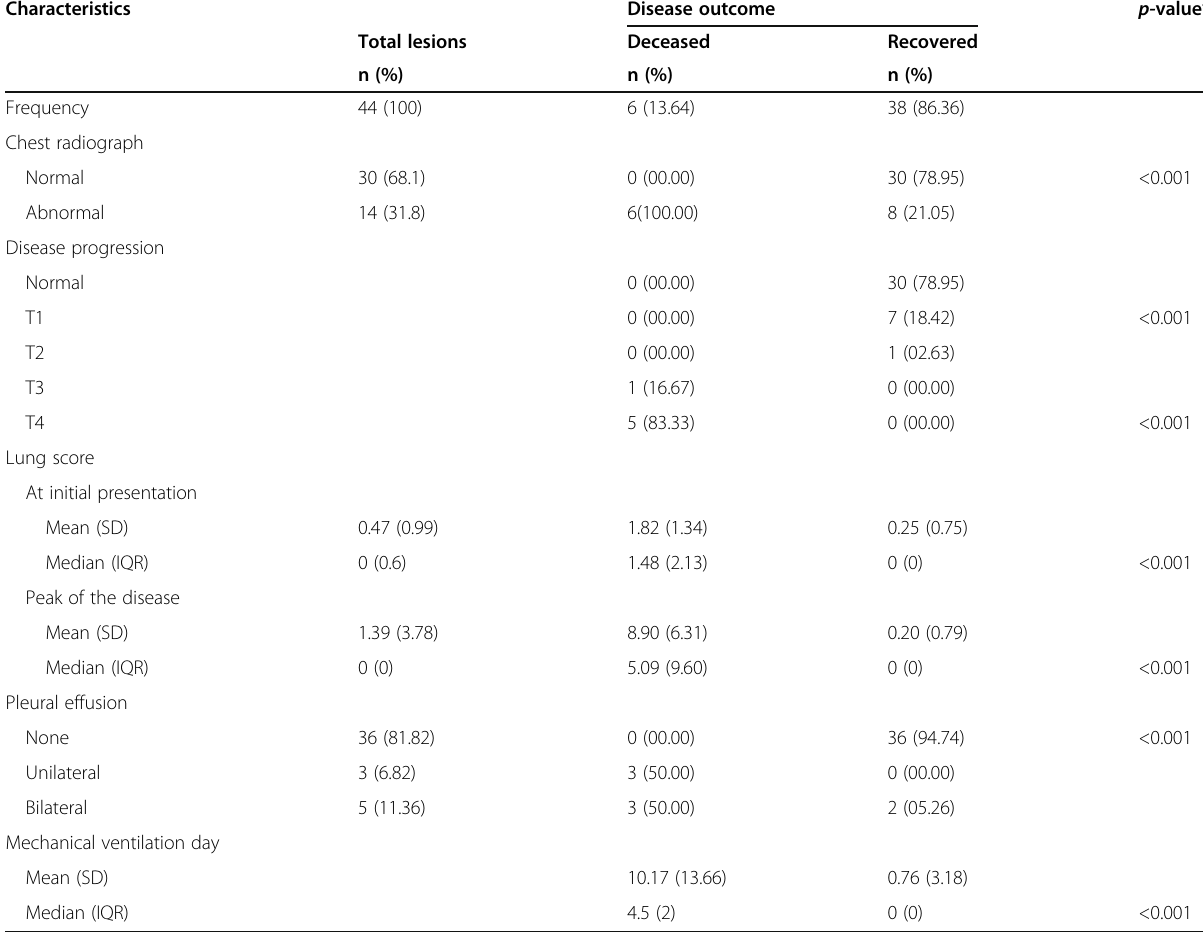
Table 2 Distribution of predictors in 44 MERS-Cov patients by final outcome